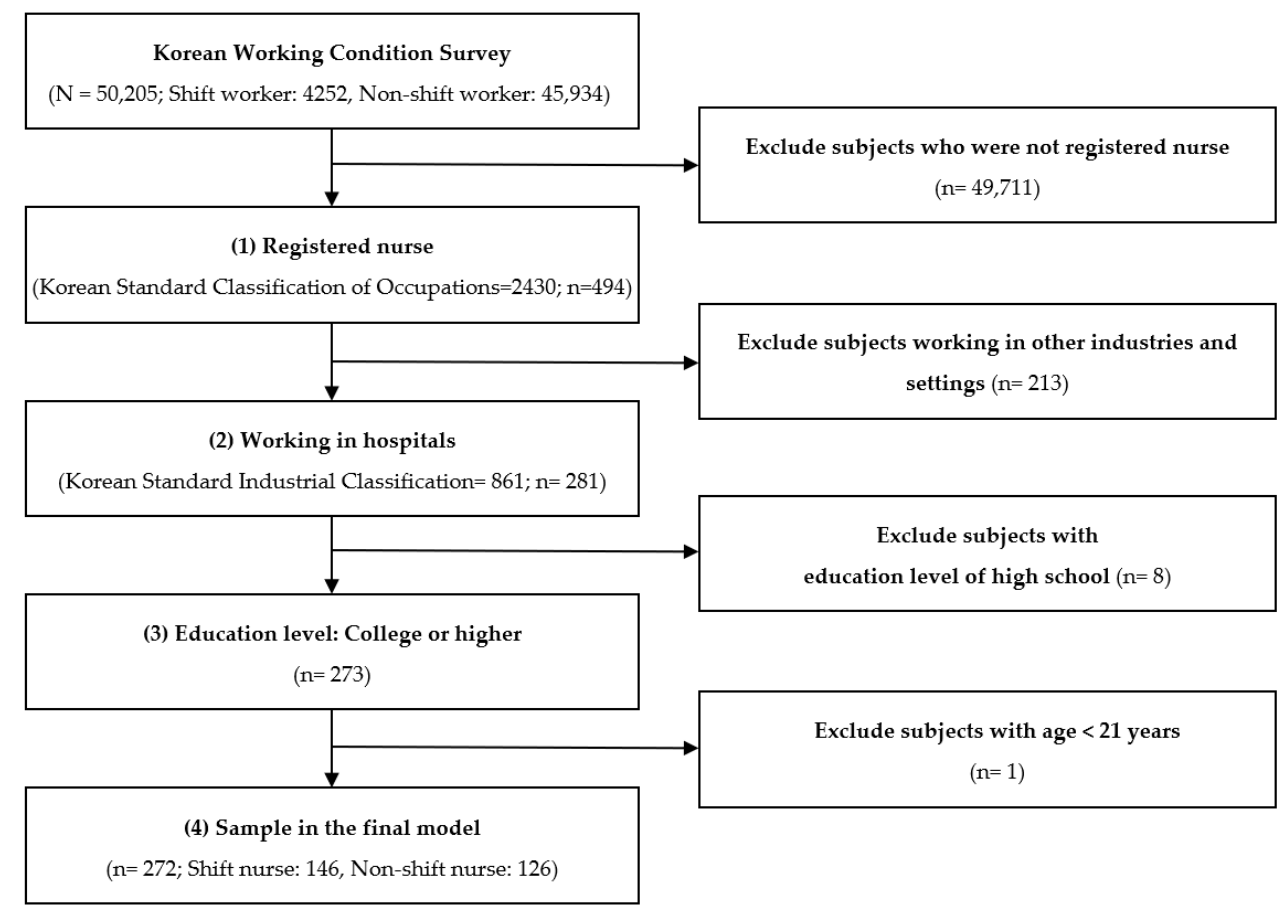
Figure 1. Flow chart of study population.